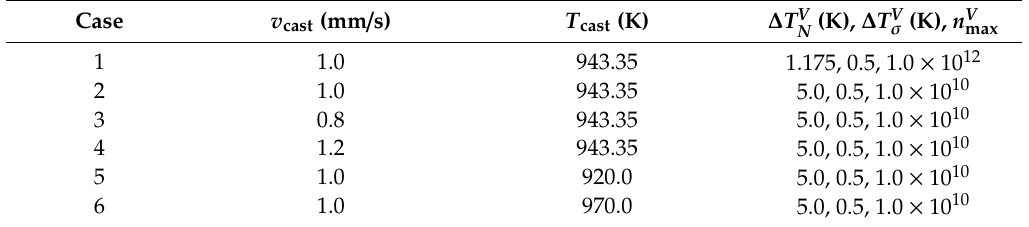
Table 2. Process parameters for di ff erent